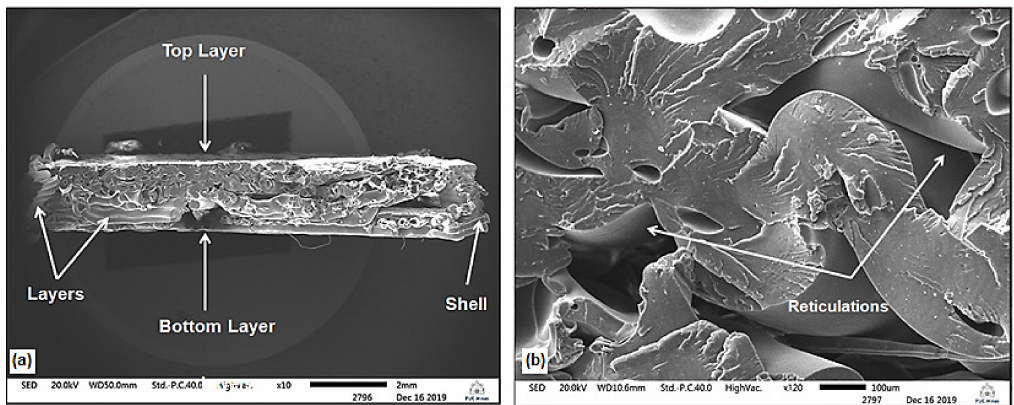
Figure 14. Microstructure images for 15% sample infill: ( a ) the deposition lines of the layers, shell, and top / bottom layer and ( b ) the internal reticulations.